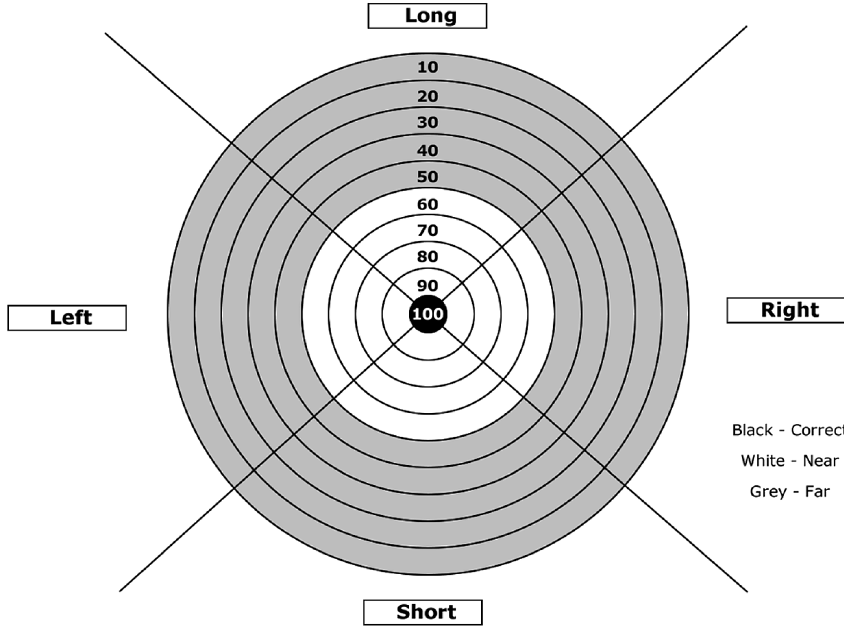
Figure 3. Target and zone areas used for providing feedback.